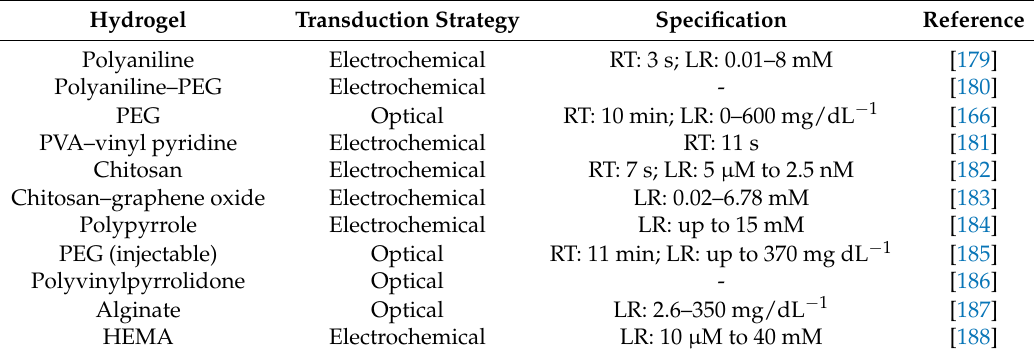
Table 4. Strategies for small biomolecule detection using hydrogel-based glucose biosensors. Hydrogel Transduction Strategy